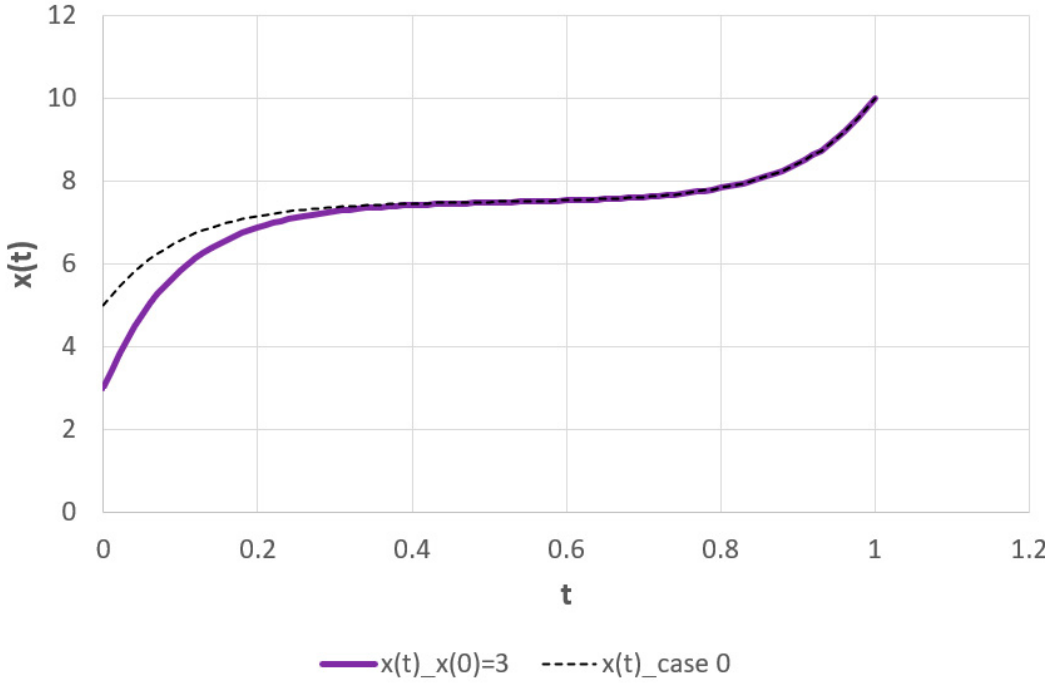
Figure 12. The optimal time path of x in Dynamic case 1.